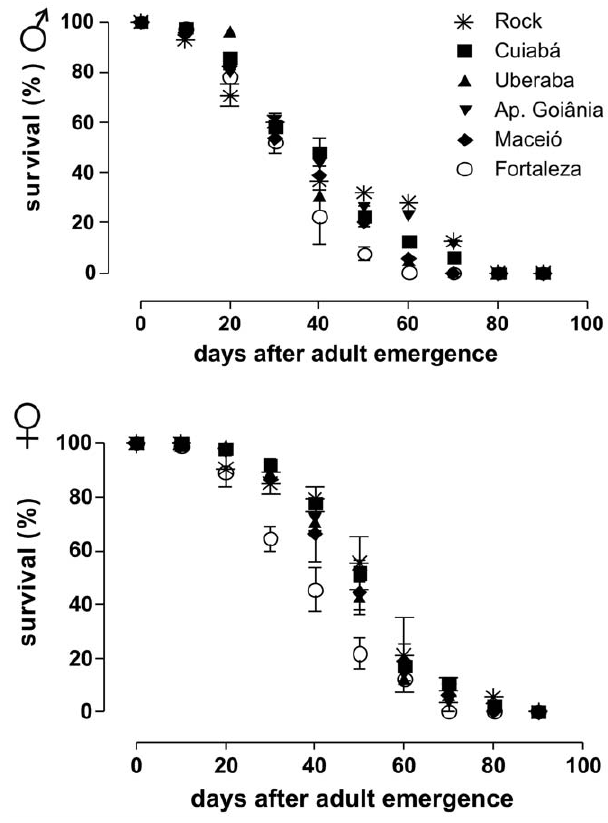
Figure 7. Adult longevity – field populations. Longevity of adults from five natural populations under laboratory conditions. Rockefeller strain (Rock) was used as an internal control of the assay. Mean percentage and standard error are presented.